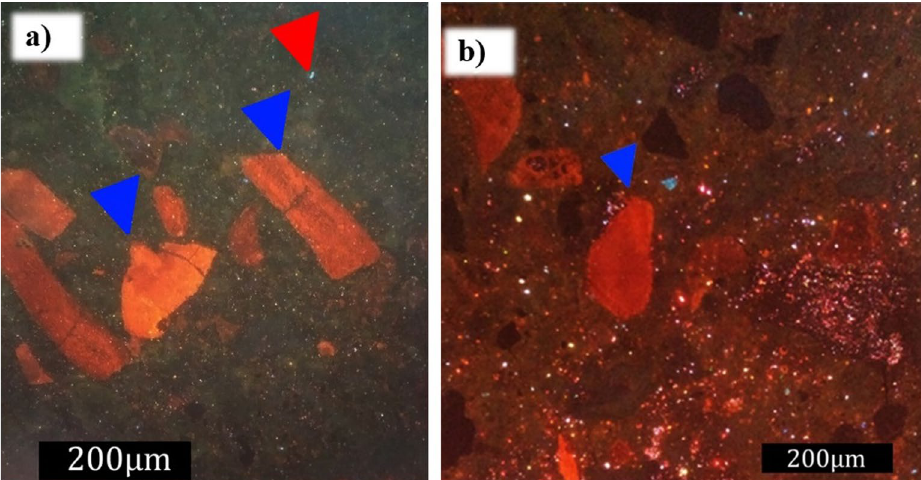
Figure 12. Image obtained from cathodoluminescence. ( a ) Detail for the Halimeda algae fragments showing red luminescence (blue arrow) and fine grains of quartz or feldspar showing a blue luminescence (red arrow). ( b ) Binding cement represented by punctual luminescence located in the matrix of the synthetic rock.